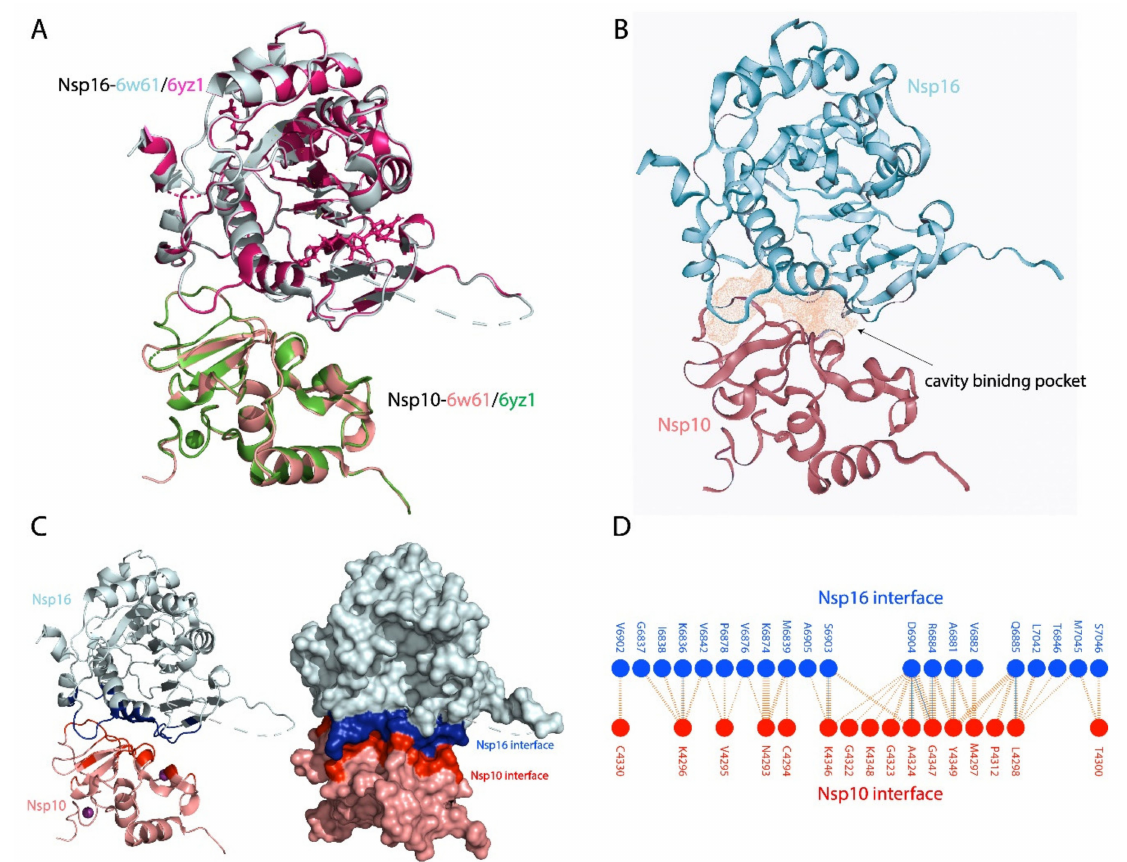
Figure 1. ( A ) Structural superposition of nsp10- 6W61 (salmon) with nsp10-6YZ1 and nsp16-6W61 (cyan) with nsp16-6WZ1 (magenta) with a root-mean-square deviation (RMSD) of 0.159 Å. ( B ) Cavity binding pocket of nsp10-nsp16 structure (6w61). ( C ) Showing the interface of the nsp10-nspa6 binding protein partners, with blue colour represents the nsp16 binding interface residues while the red colour represents the nsp10 binding residues. The right panel in the ( C ) shows the nsp10-nsp16 complex as surface. ( D ) Schematic of the bonding interactions between interface residues of nsp10 (red) and nsp16